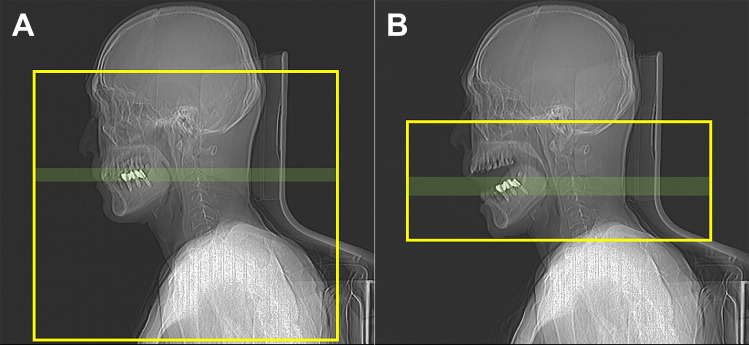
Field-of-view (yellow box) and imaging plane (green box) on lateral scout images of conventional (A) and open mouth (B) computed tomography.